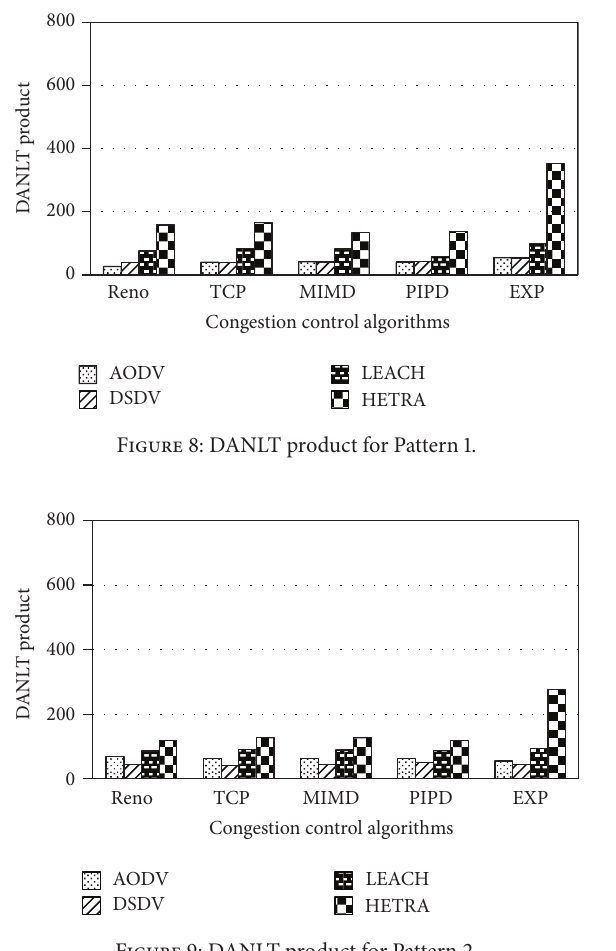
Figure 11: DANLT product for Pattern